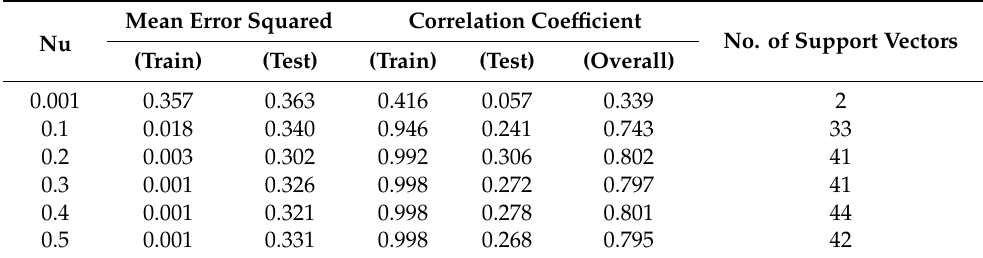
Table 4. Nu-RBF performance utilizing di ff erent values of Nu with fixed (gamma = 8, capacity = 8.5) of Total behavior prediction